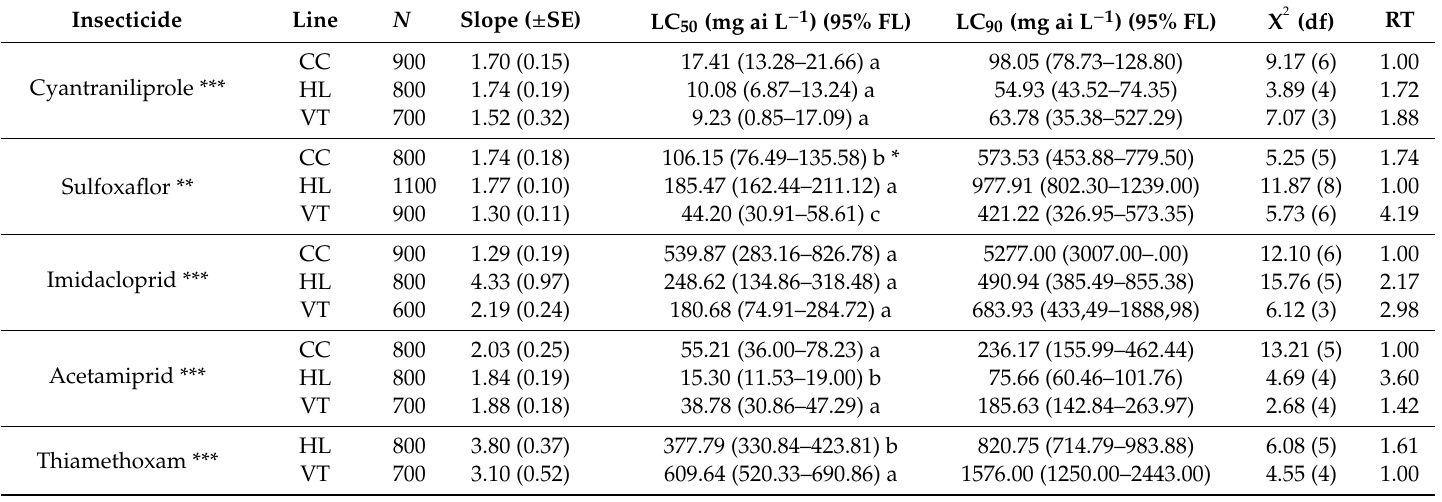
Table 2. LC 50 and LC 90 values in di ff erent populations of Bemisia tabaci MED collected in 2017–2018 for the insecticidal molecules sulfoxaflor, imidacloprid, acetamiprid, thiamethoxam, and